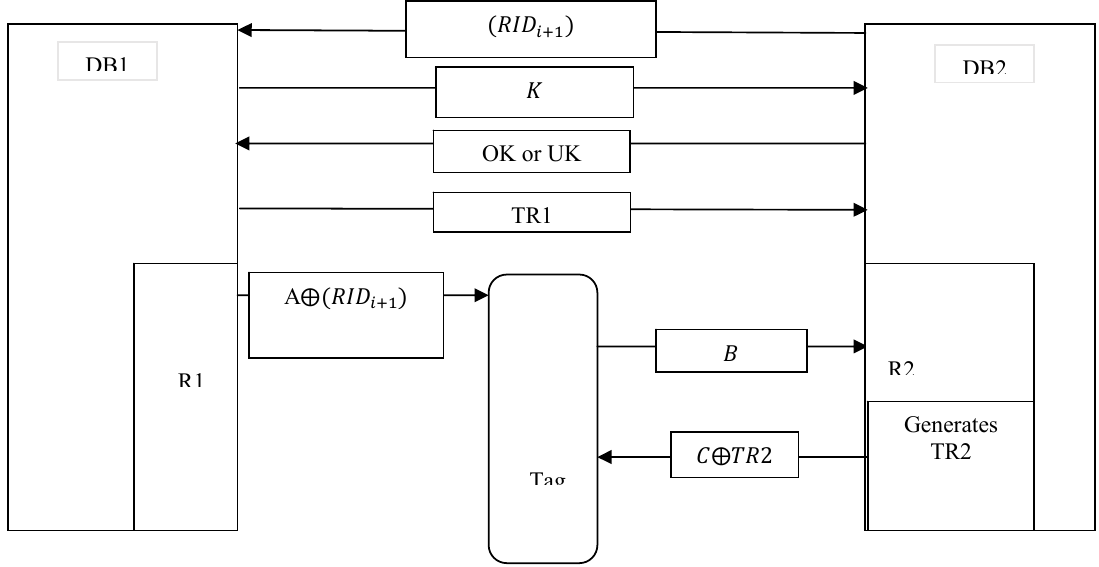
Figure 3: Details of the proposed protocol Scenario